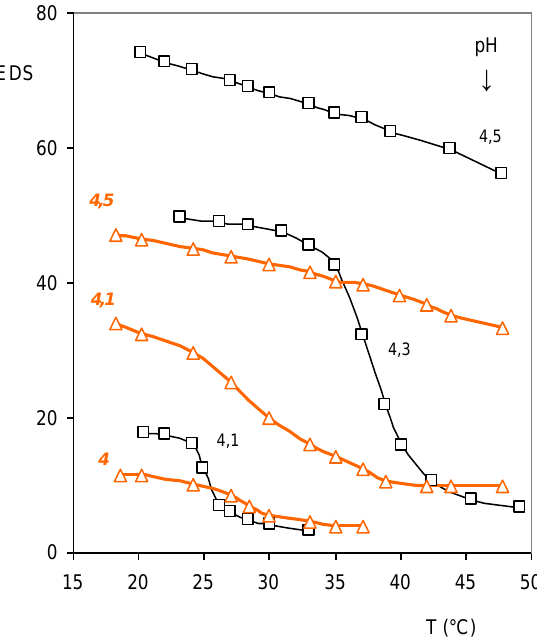
Figure 4. Equilibrium degree of swelling (EDS) in relation to the temperature (°C) for the hydrogel AVa-2 in acetate buffers of different pHs (squares, 0.05 M in water; red triangles, 0.01 M in 0.15 M